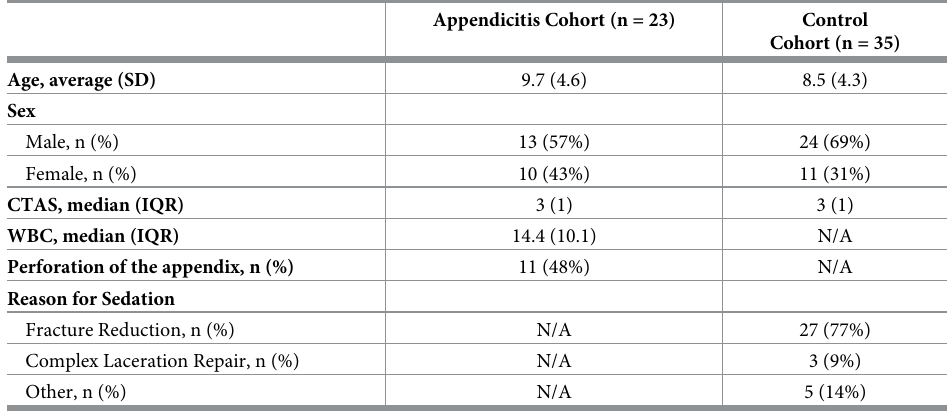
Table 1. Demographic and clinical description of the appendicitis and control patient